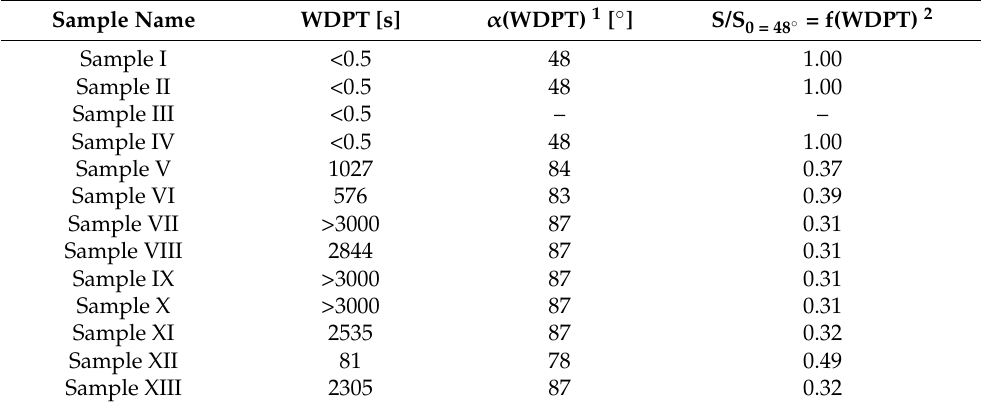
Table 2. Values of the water drop penetration time, WDPT, effective contact angle α , and relative sorptivity S/S 0 for the 13 studied sample